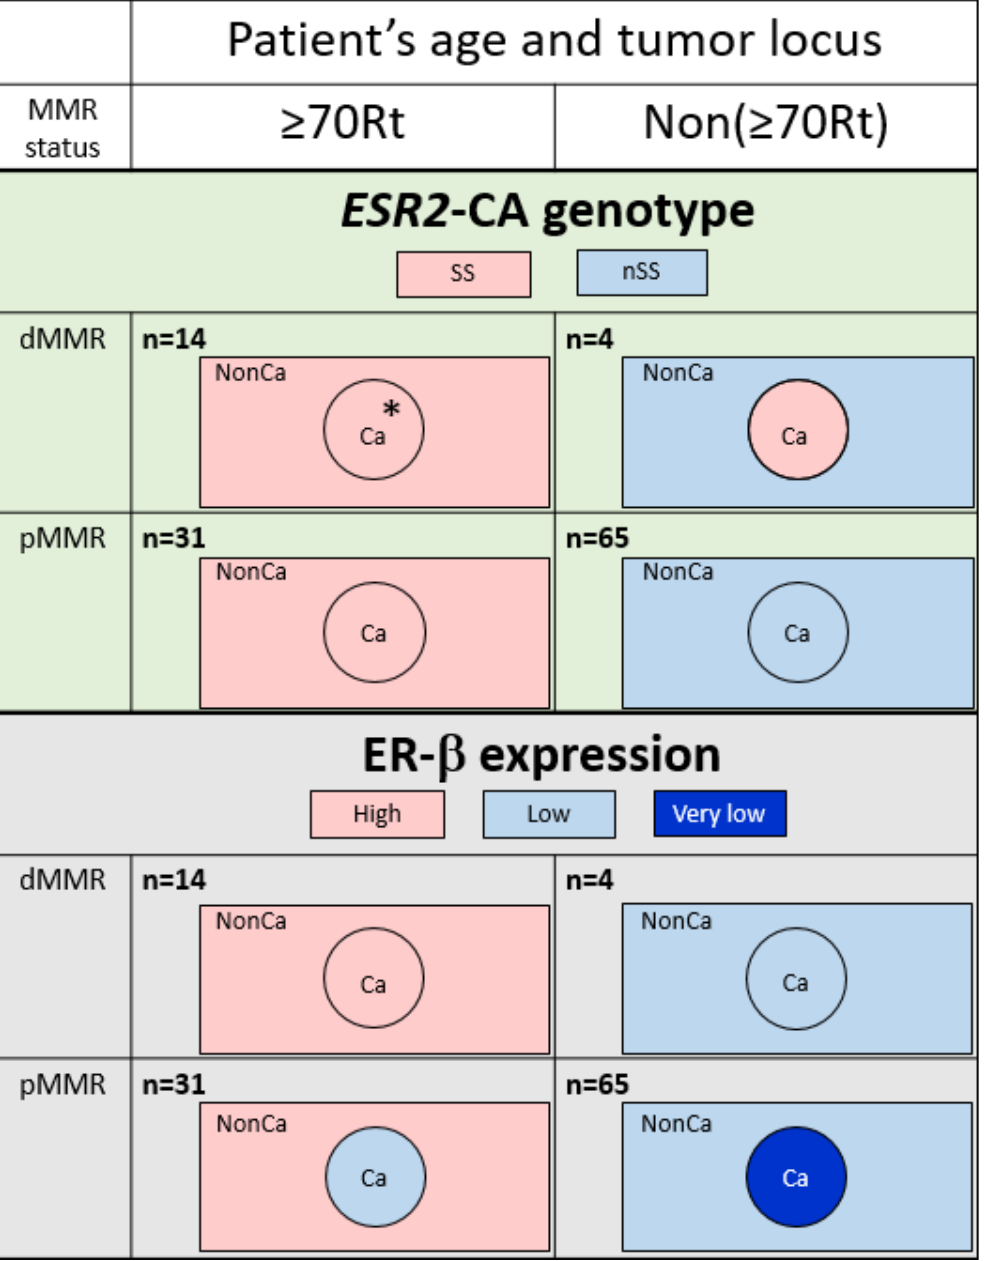
Figure 3. Typical feature of ESR2 cytosine-adenine ( ESR2 -CA) genotype ( above ) and ER- β expression ( below ) according to the categories determined by patients’ age/tumor locus (right-sided case ≥ 70 y/o, ≥ 70Rt vs. the others, Non( ≥ 70Rt)) and mismatch repair protein status (MMR-deficient, dMMR vs. MMR-proficient, pMMR). The number of ESR2 -CA repeats frequently varied in dMMR tumors; however, no change was produced in the genotype in ≥ 70Rt/dMMR (*). A decrease of ER- β expression in Ca compared with NonCa was observed only in pMMR tumors. Ca, cancerous tissue; NonCa, non-cancerous